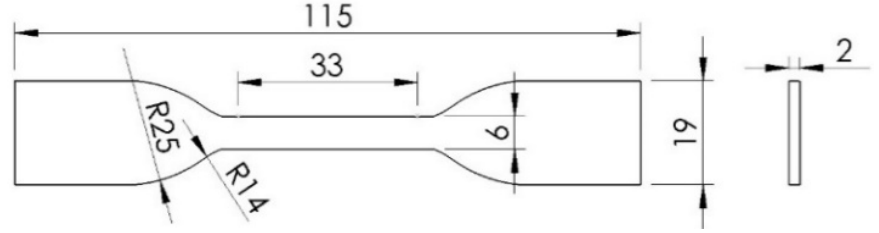
Figure 2. The specimen dimensions (mm) for the tensile test.